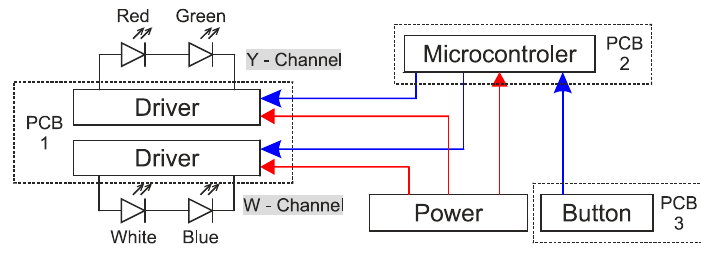
Figure 8. Block diagram of electronics in defensive device.